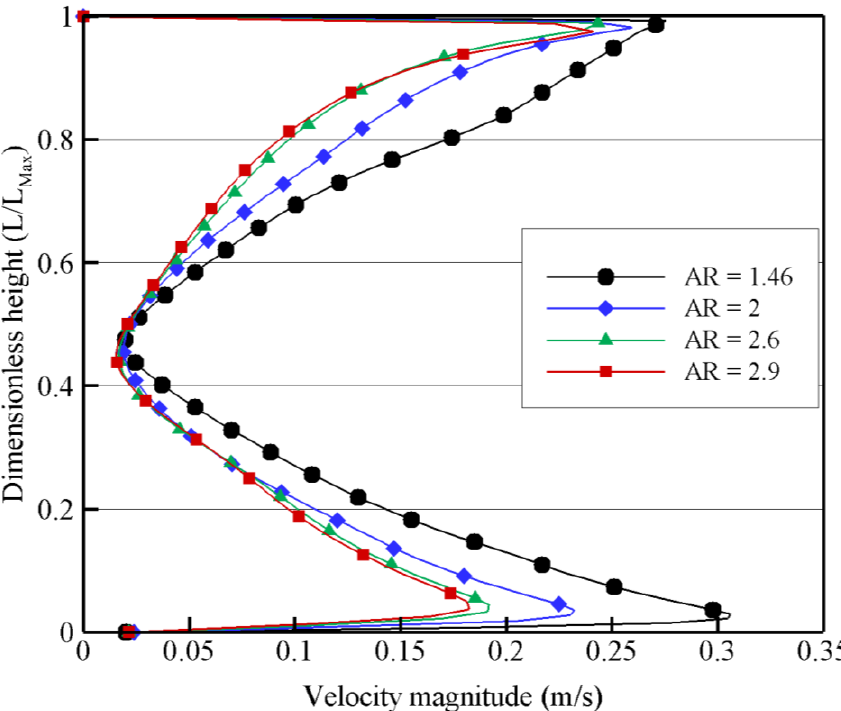
Figure 10. Local velocity at θ = 30° for different aspect ratios.